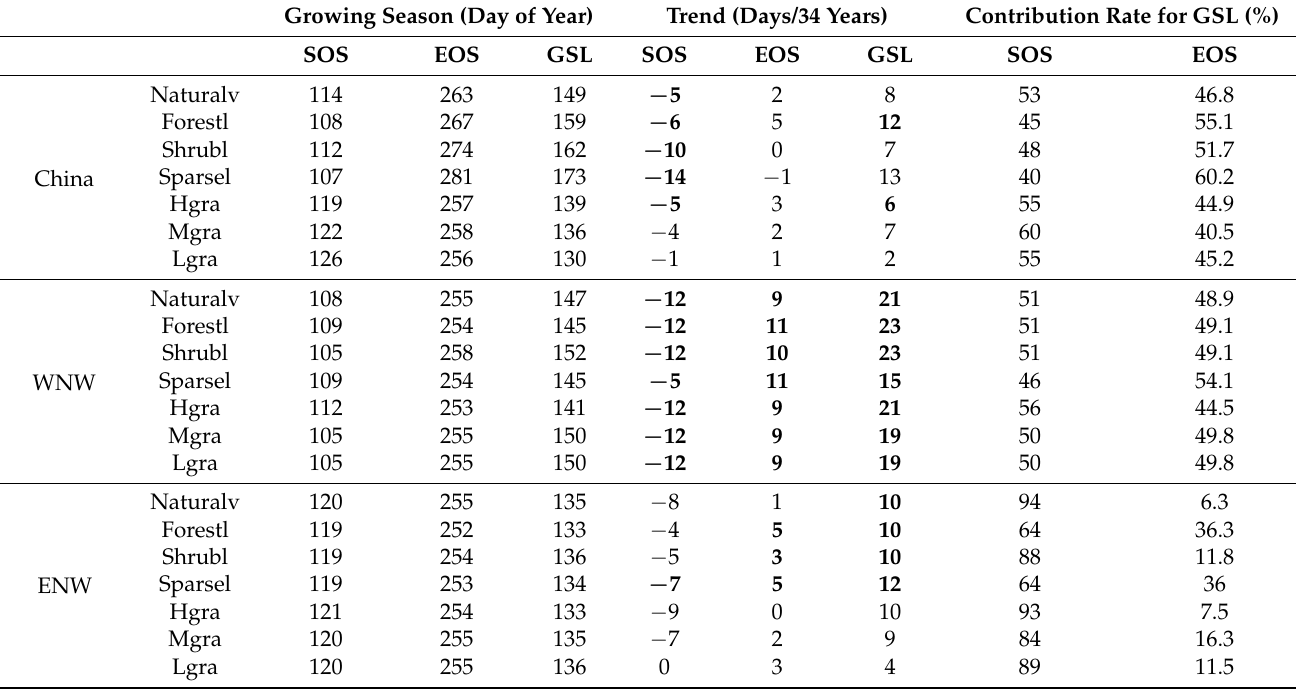
Figure 4. The temporal and spatial changes to the start of the growing season (SOS; ( a , d )), end of the growing season (EOS; ( b , e )), and growing season length (GSL; ( c , f )) in China (SD—Significant decrease trend; ISD—Insignificant decrease trend; ISI—Insignificant increase trend; SI—Significant increase trend). Table 2. The mean and trends in the start of growing season (SOS), end of growing season (EOS), and growing season length (GSL) in China (significant trends at 0.05 significance level are indicated in bold).